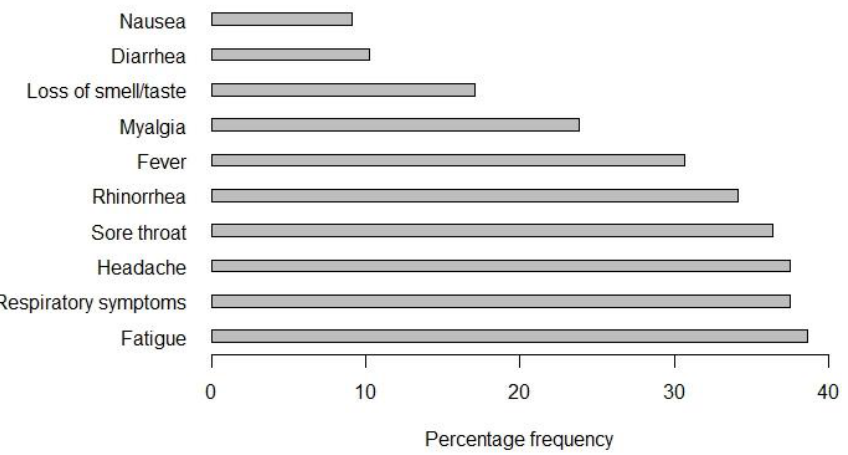
Figure 3. Percentage frequencies of common symptom reported by individuals with SARS-CoV-2 neutralizing antibodies.